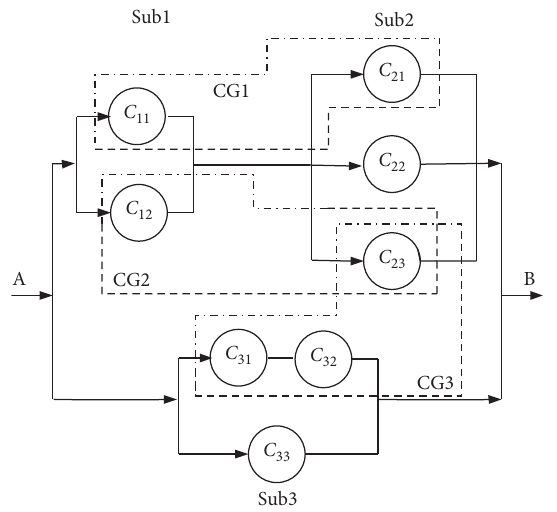
Figure 6: System topology of numerical example.